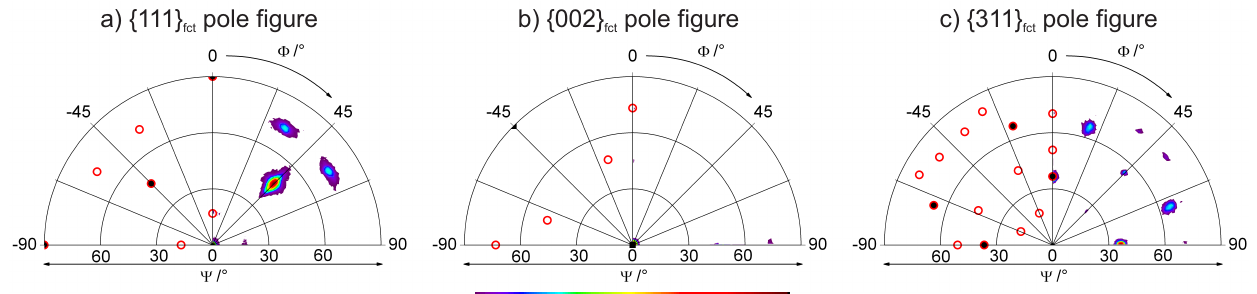
Comparison of measured pole figure of a Fe quadrant) with simulations of bcc-type { 112 } ( b ) { 002 } and ( c ) { 311 } . Black squares represent the epitaxial matrix and the red circles, fct fct the first twin